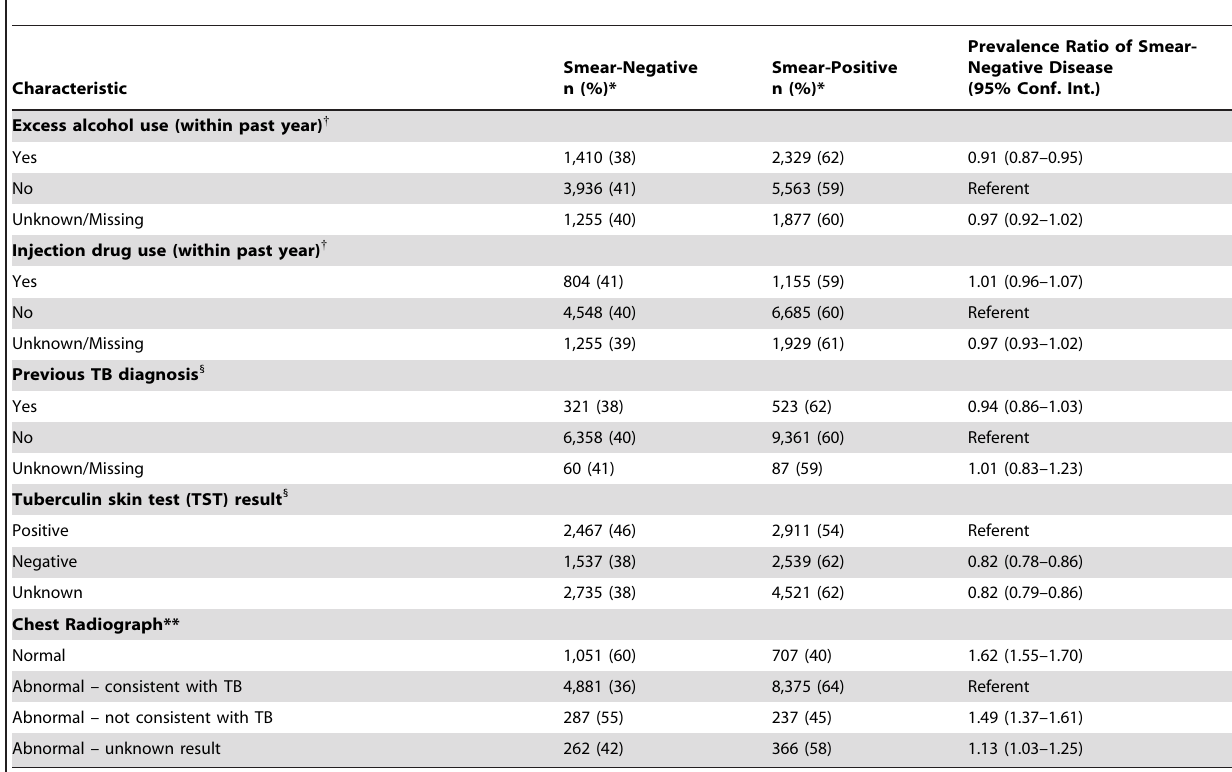
Table 2. Behavioral and Clinical Characteristics of Patients with HIV-Infection and Culture-Confirmed Pulmonary TB, by Sputum Smear Result, United States,